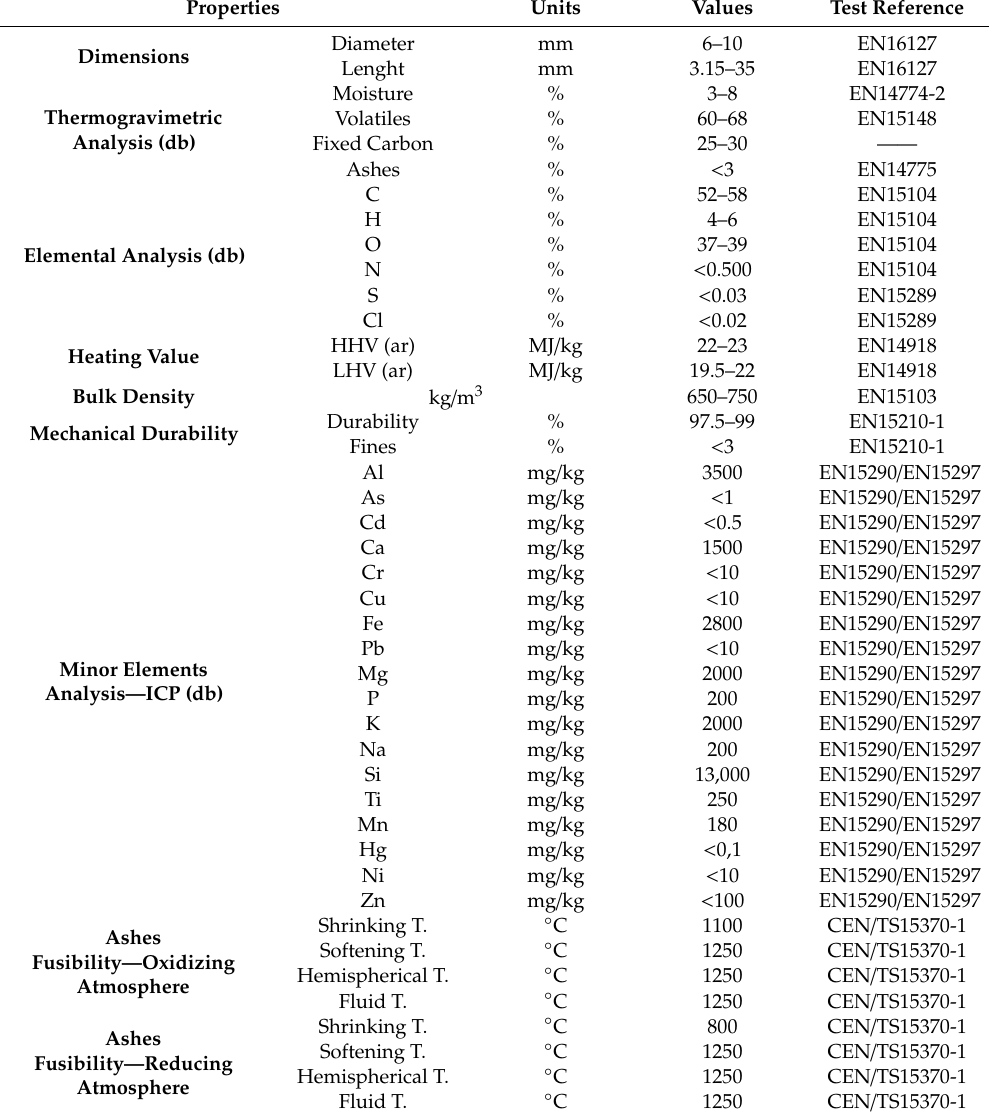
Table 1. Summary of the results obtained during the di ff erent phases of tests carried out between 2013 and